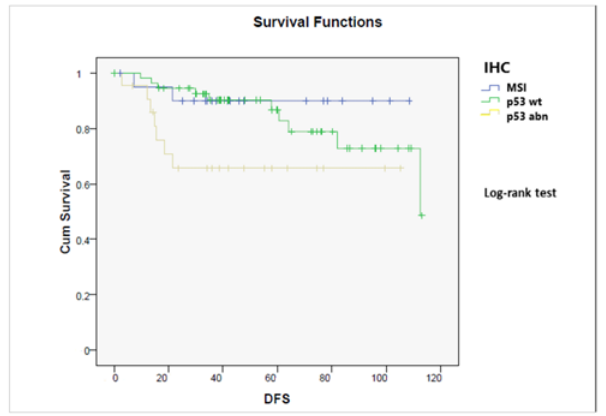
Figure 5. Disease ‐ free survival stratified by immunohistochemical (IHC) status (MMR ‐ deficient, Figure 5. Disease-free survival stratified by immunohistochemical (IHC) status (MMR-deficient, p53 ‐ mutated, p53 wild ‐ type) ( p = 0.05). p53-mutated, p53 wild-type) ( p =